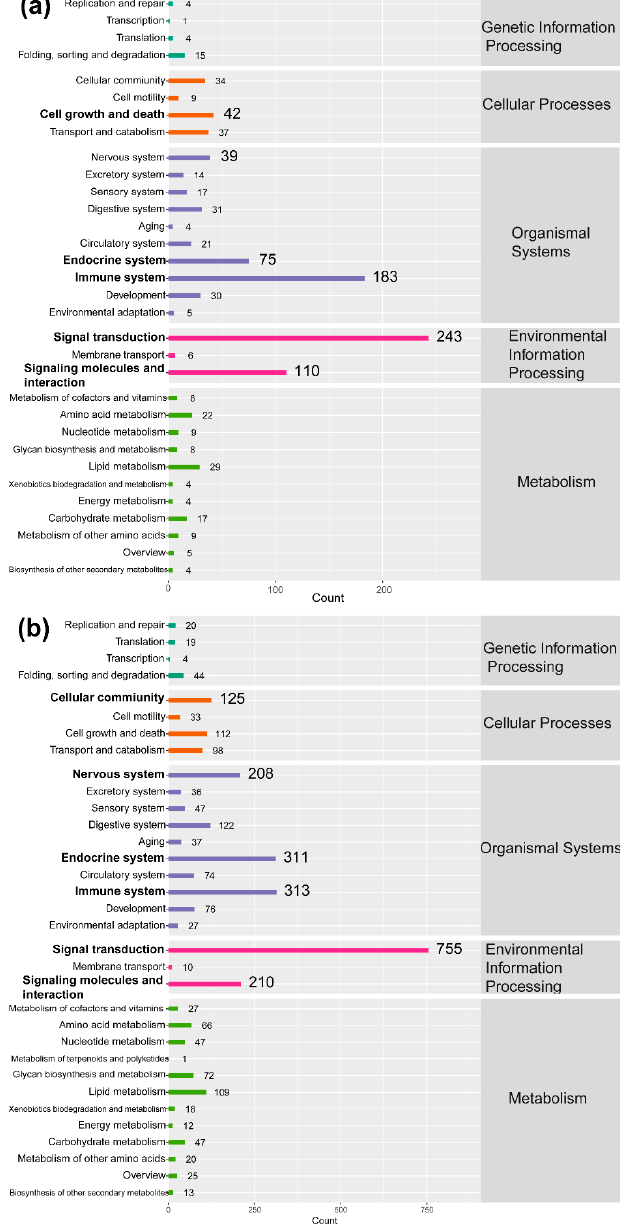
Figure 5. Kyoto Encyclopedia of Genes and Genomes (KEGG) enrichment analysis at 12 ( a ) and 24 h post ‐ infection ( b ). The top six enriched KEGG terms at both the time points are marked in black bold font.